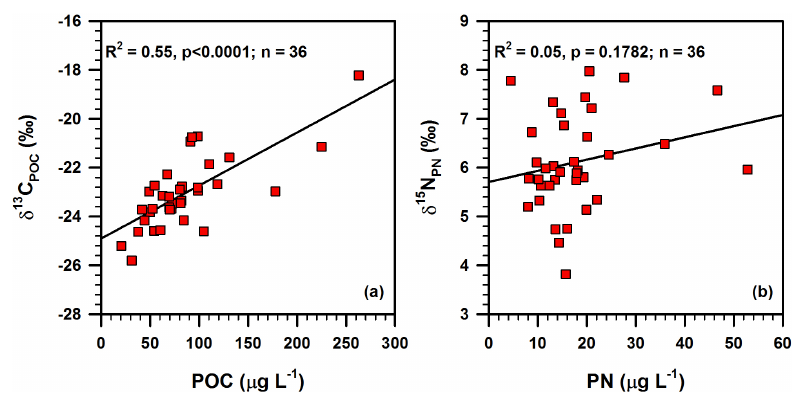
Figure 10. Bi-plots showing the relationships of (a) δ 13 C POC vs. POC and (b) δ 15 N PN vs. PN in suspended particulate matter around the deep chlorophyll maximum layer in the southern East China